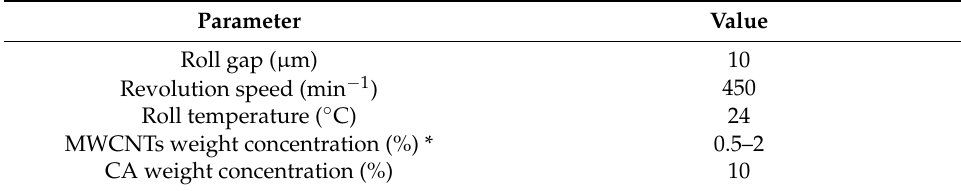
Table 3. Parameters of three-roll mill